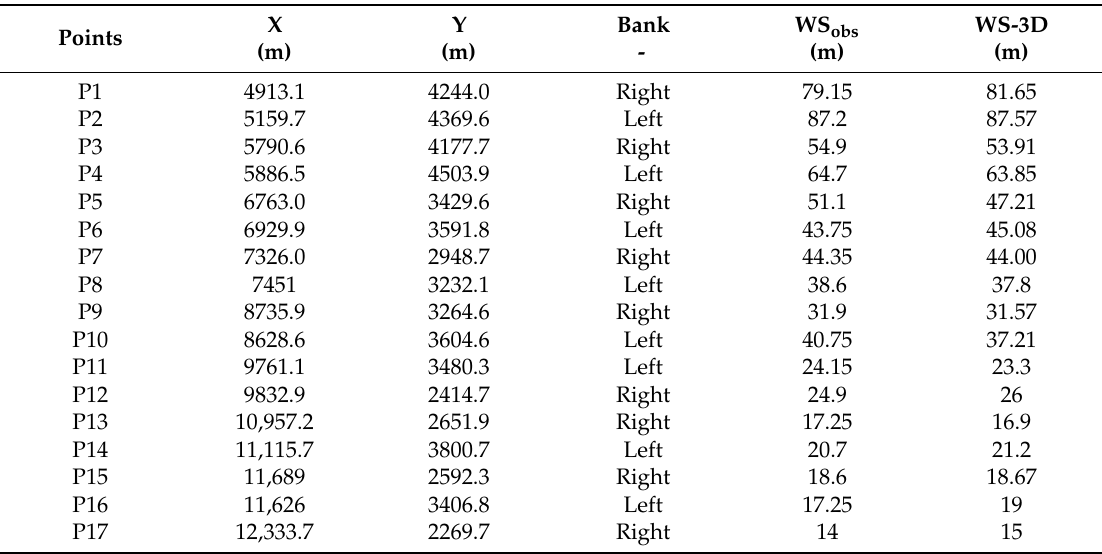
Table 3. Maximum water levels at the gauge points P1–P17: data surveyed by the local police after the dam break (WS obs ), and 3D model results